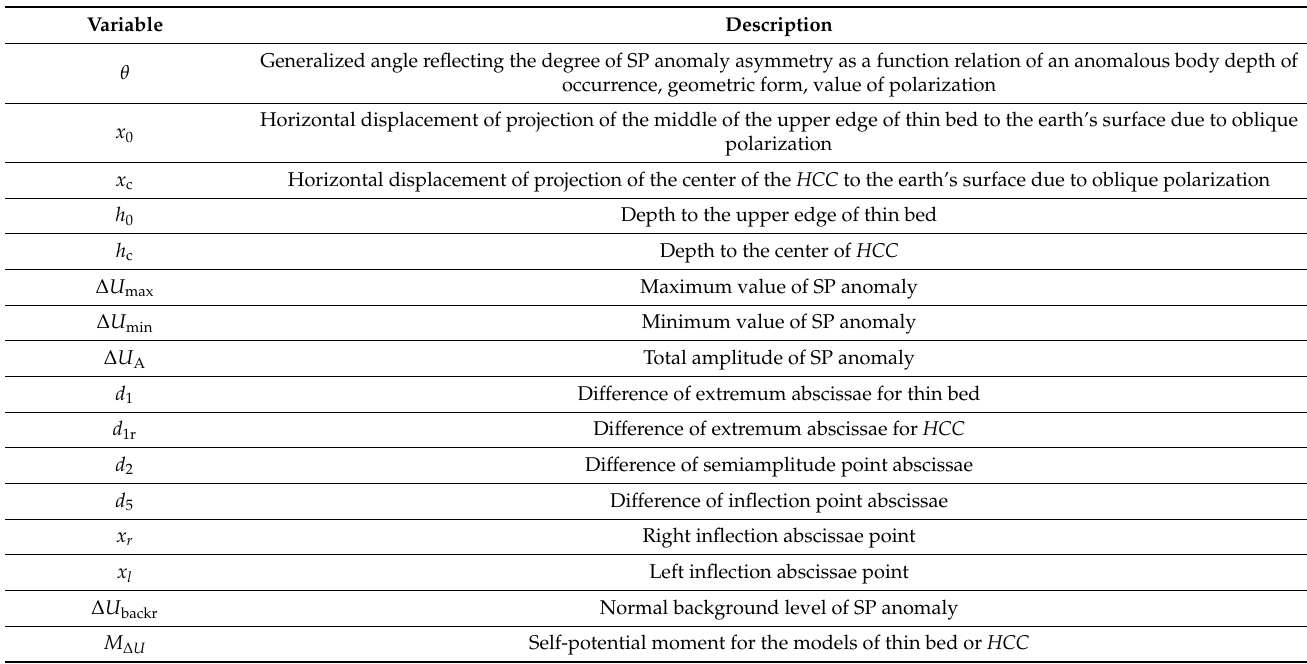
Table 4. Nomenclature of variables applied for quantitative analysis of SP anomalies due to of thin bed and horizontal circular cylinder models (see Table